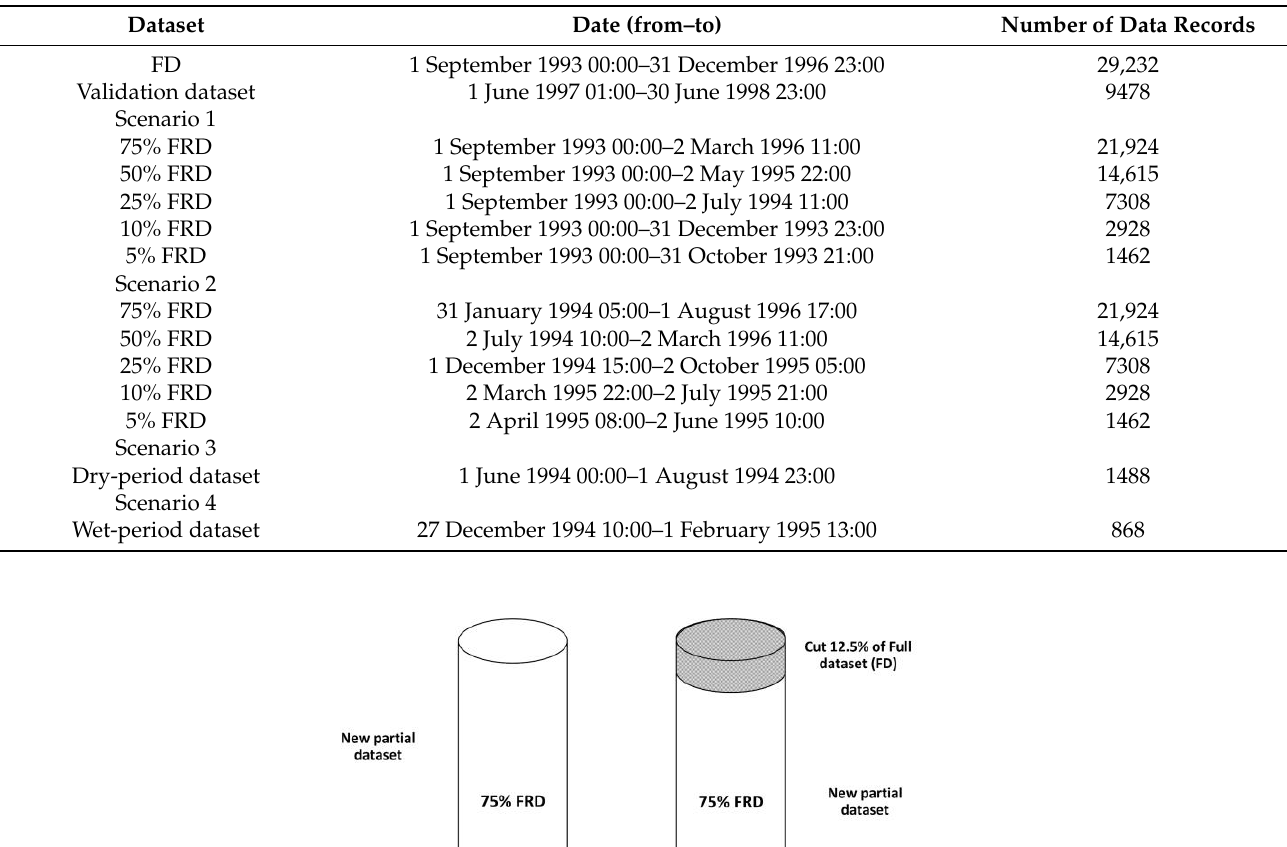
Table 2. Datasets used in the study.